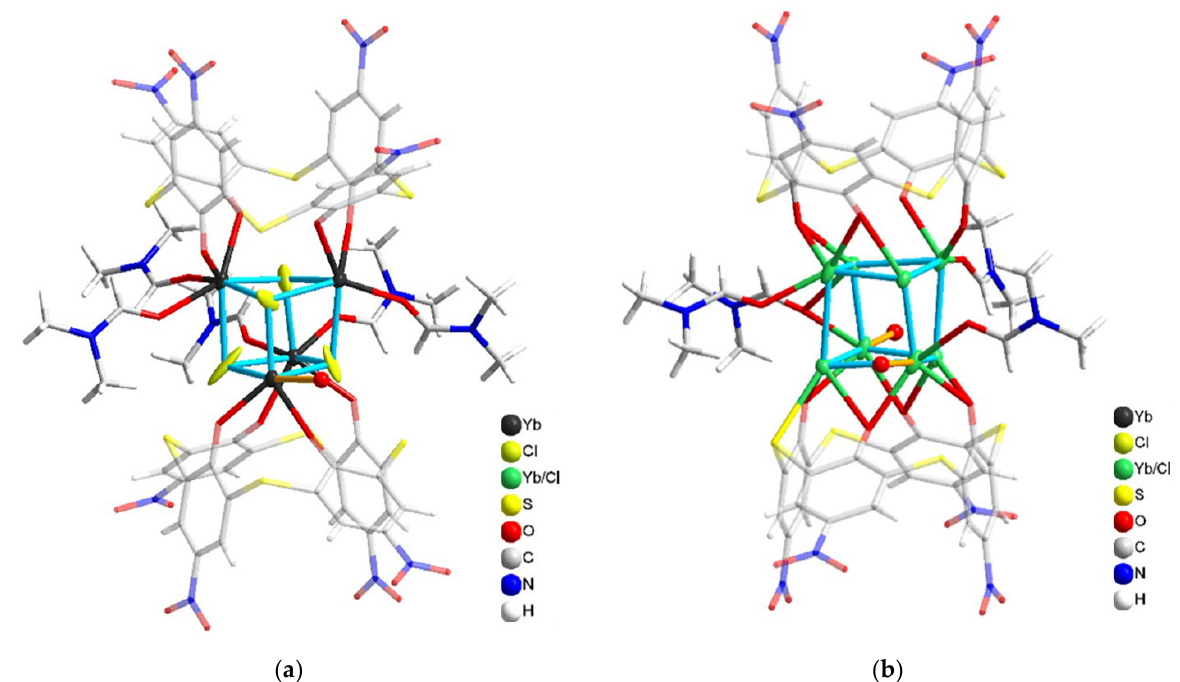
Figure 4. Ligands coordinated to the Yb 4 Cl 4 “cube”: ( a ) with separated Yb and Cl positions. Cl atoms are disordered and not bonded to ligands; ( b ) with mixed Yb and Cl positions. L 4 − anions are plotted semi-transparent. A water molecule is represented by an oxygen atom plotted as a red ball.